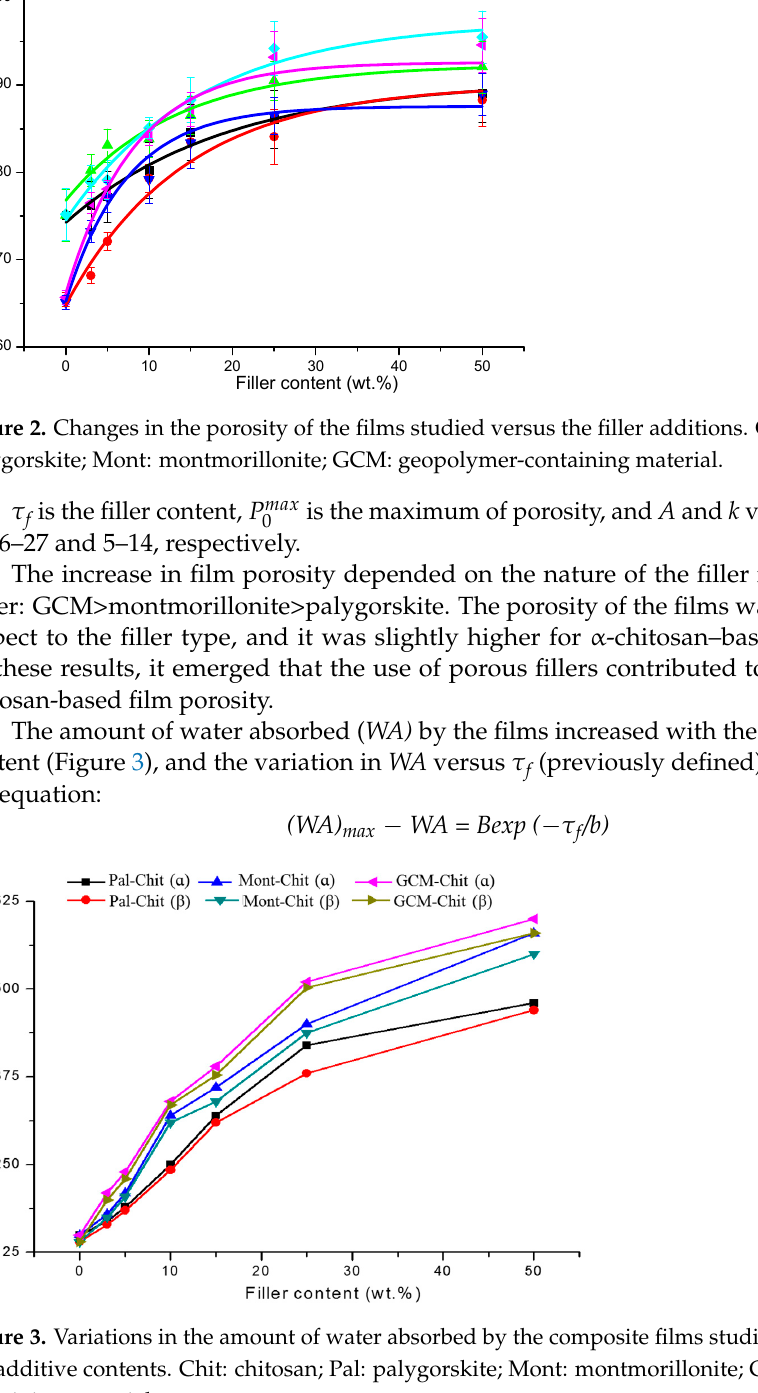
Figure 4. Evolutions of water solubility of the films against filler content. Chit: chitosan; Pal: palygorskite; Mont: montmorillonite; GCM: geopolymer-containing material.